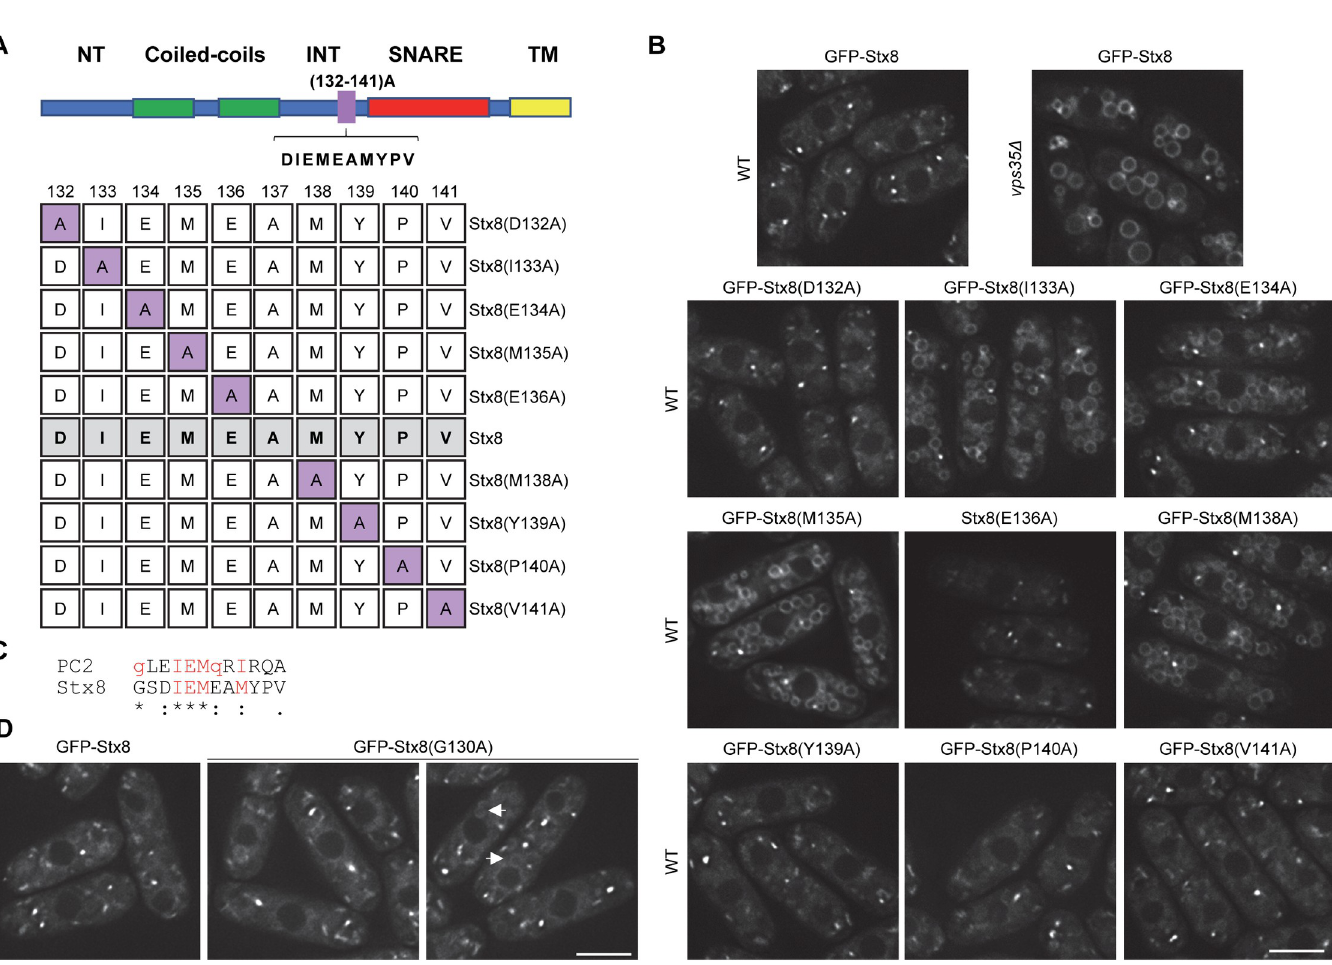
Fig 6. Residues 133 I, 134 E, 135 M and 138 M are essential for Stx8 recycling from the prevaculoar endosome (PVE). (A) Upper panel: Sequence and relative position of the residues subjected to alanine-scanning mutagenesis. Lower panel: Sequence and name of the Stx8 variants produced by the mutagenesis. The numbers at the top indicate the position of the residue that was mutated. The lane denoted as Stx8, shaded in grey, corresponds to the native protein, where the residue at position 137 is an alanine. Purple squares indicate the residues mutated to alanine. (B) Distribution of the indicated Stx8 variants. The localization of native Stx8 in wild type (WT) and vps35 Δ backgrounds are shown for comparison (upper panels). (C) Alignment of Stx8 and human polycystin-2 (PC2) motifs involved in protein recycling by retromer. The residues that participate in the process are in red font, and essential residues are in capital letters. (D) Localization of Stx8(G130)A in WT cells. Arrows denote vacuoles with mild fluorescence at their surface. Images are single planes captured with a DeltaVision system. Scale bar, 5 μ